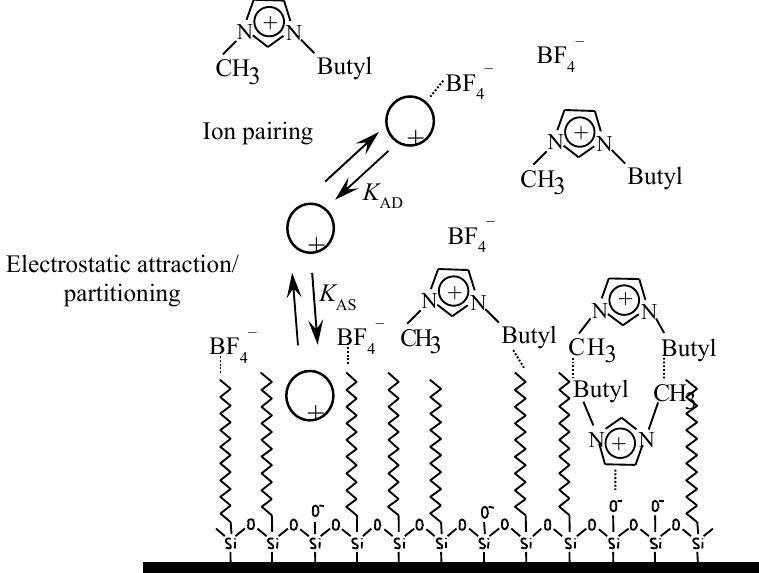
Figure 1. Solute environment in an octadecylsilane (C18) stationary phase in the presence of [C 4 MIM][BF 4 ] .